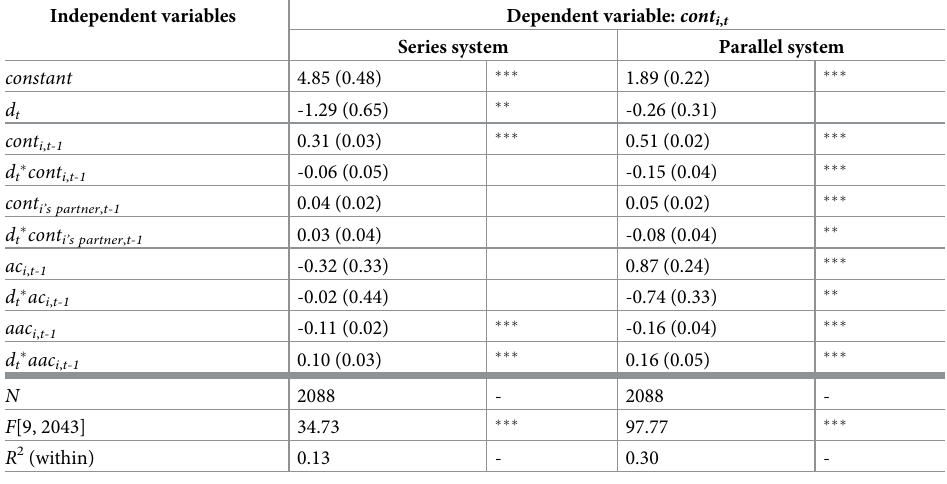
Table 5. Regression analysis on